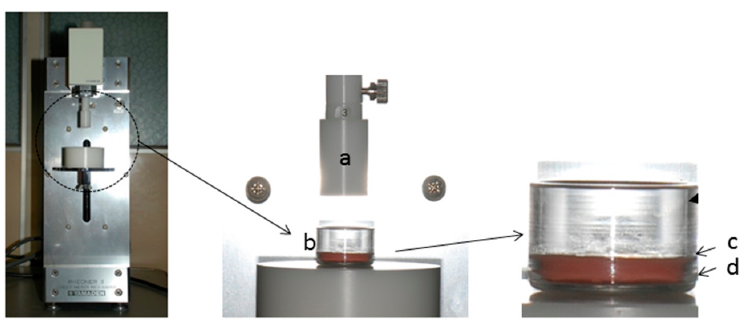
Figure 1. Creep meter ( Left ) and its compressive condition ( Center , Right ). ( a ) Plunger; ( b ) Glass dish; ( c ) Type 1 collagen cell desk; ( d ) Silicone impression material.